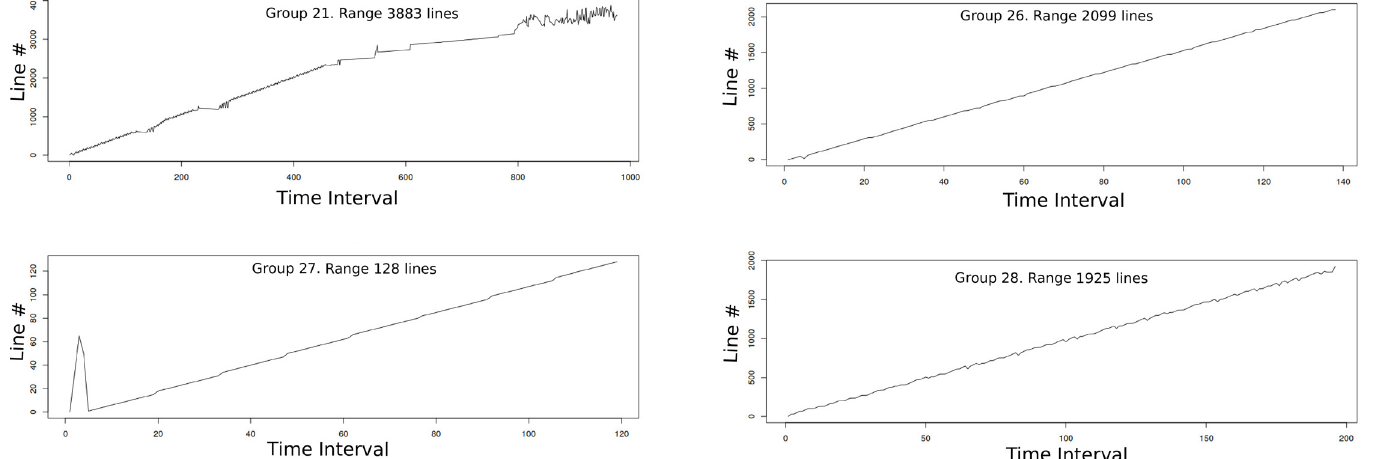
PLOS ONE | https://doi.org/10.1371/journal.pone.0257047 September 14,